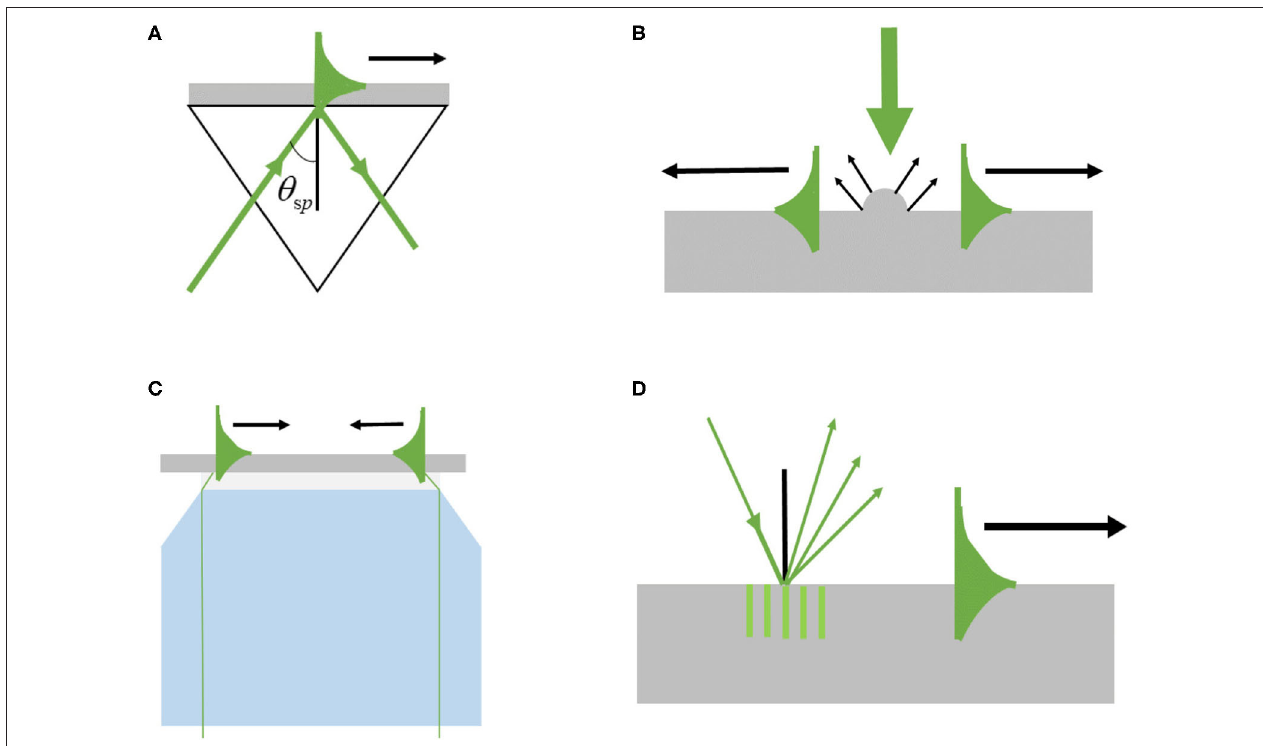
FIGURE 3 | Common excitation methods for surface plasmon polaritons (SPPs). (A) Prism-coupled excitation; (B) Near-field scattering excitation; (C) Tight focus excitation; (D) Grating